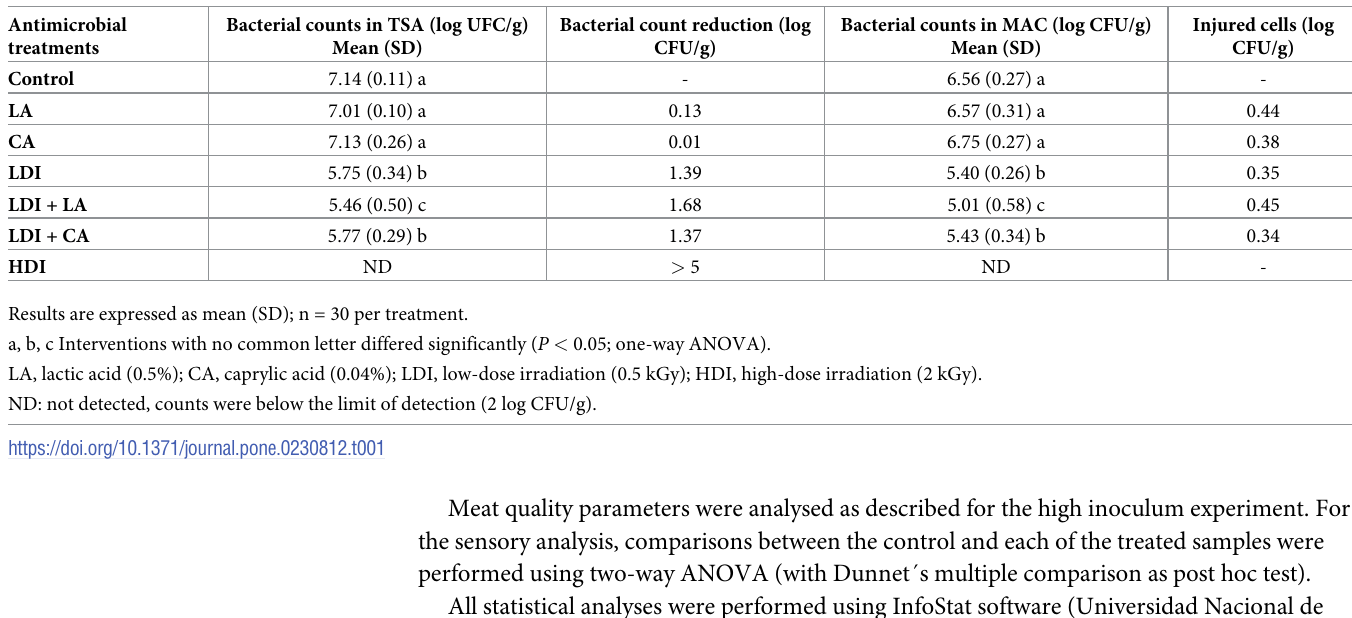
Table 1. Antimicrobial treatment effects on bacterial count reduction (log CFU/g) of beef trimmings inoculated with STEC by plating on triptic soy agar (TSA) and MacConkey agar (MAC). Antimicrobial treatments